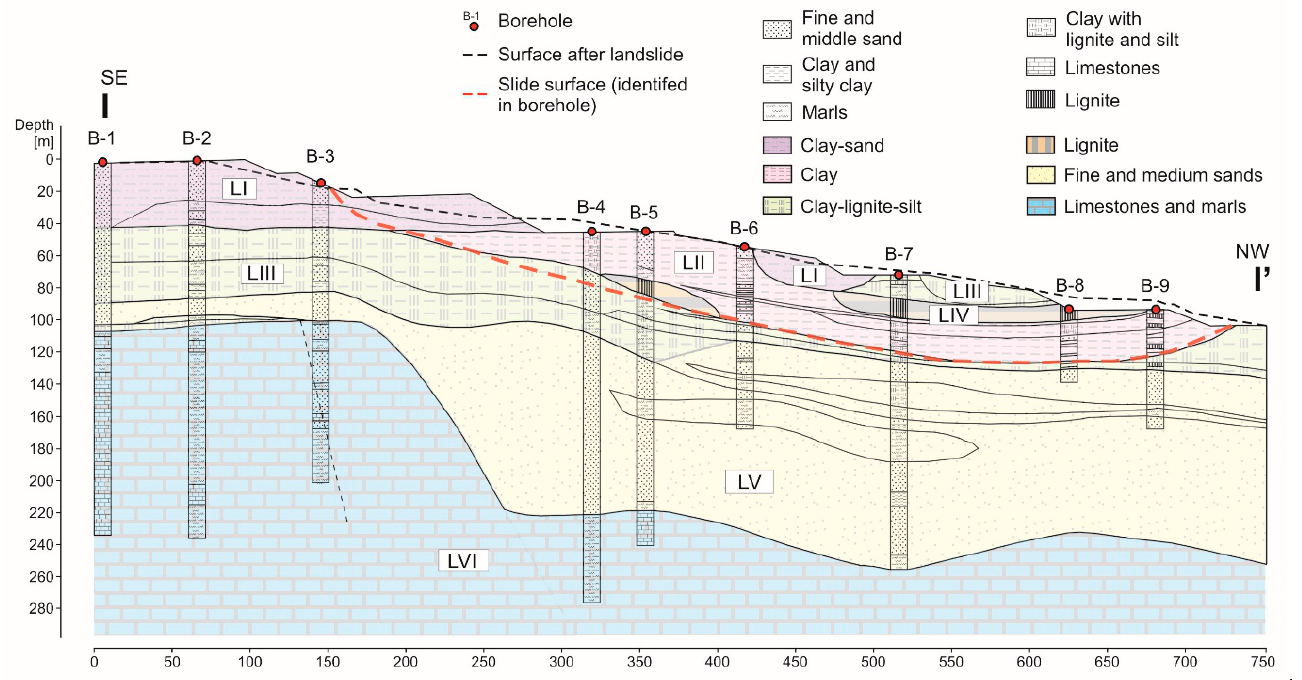
Figure 8. Cross-section I-I’ along the longitudinal axis of the landslide.